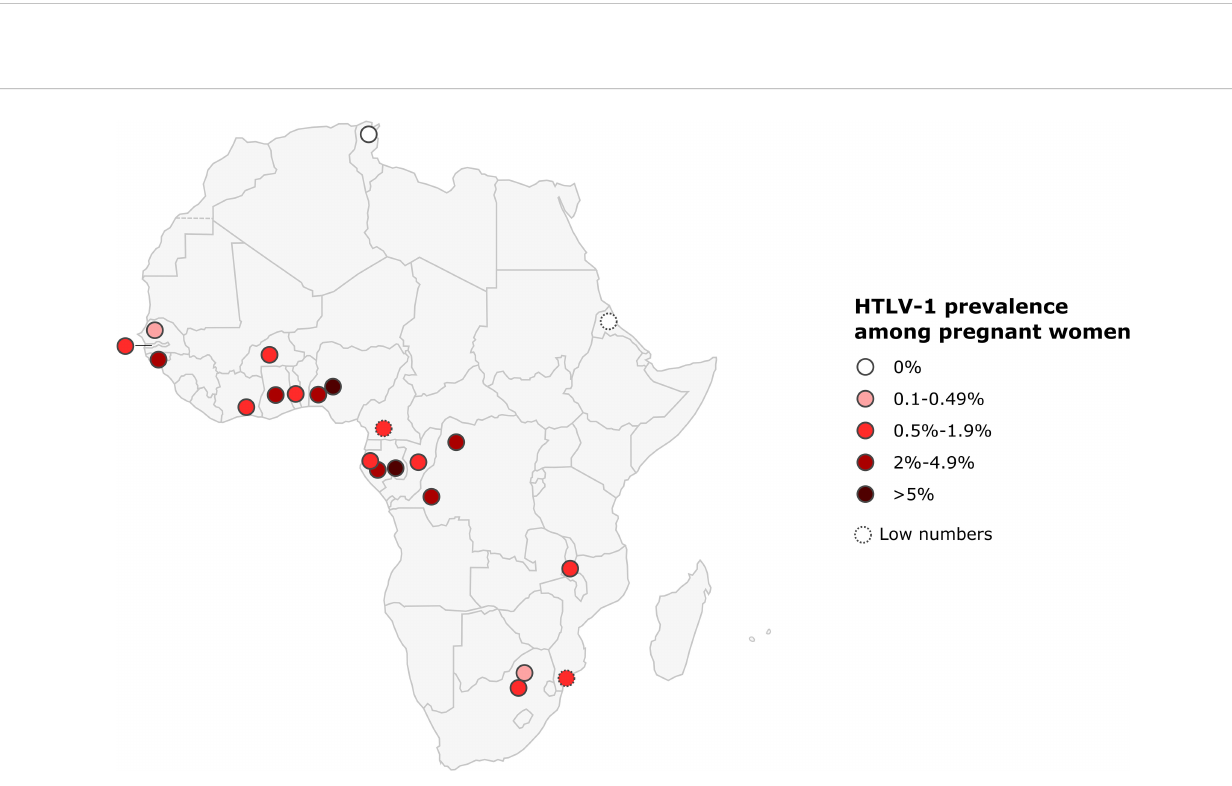
FIGURE 4 Map of Africa showing location and results of HTLV-1 prevalence studies among pregnant women. The range of HTLV-1 prevalence is indicated by color of red gradient. In case of great geographical or inter-studies variations in prevalence within a country, each result was represented separately at the site of the study location (when available). Studies with low numbers (below 150) are indicated with a dashed